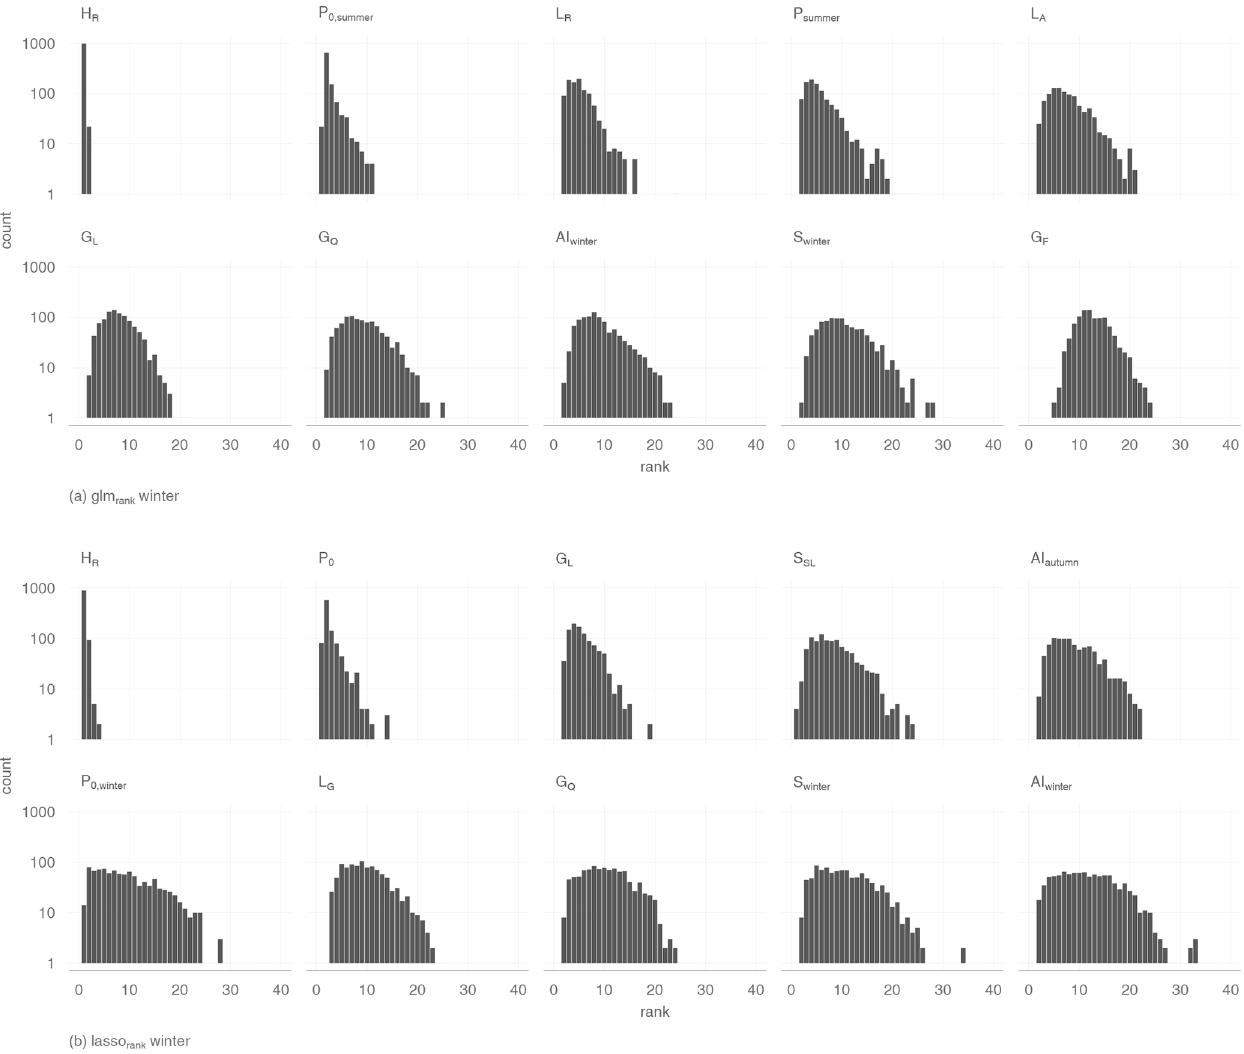
Figure 7. Count of all variable rankings of all 1000 iterations on a log scale for winter low flow. The 10 best variables are listed after their averaged